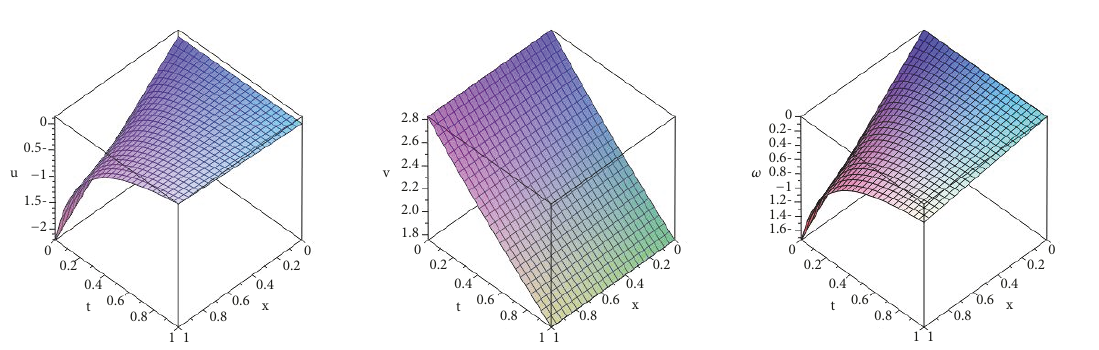
Figure 12: Surface of 𝑢 , V , and 𝜔 for M = 7 , 𝑆 = −15 , 𝛾 = 0.5 , 𝑦 = 1 , 𝛼 = −4 , 𝑙 = 2 .